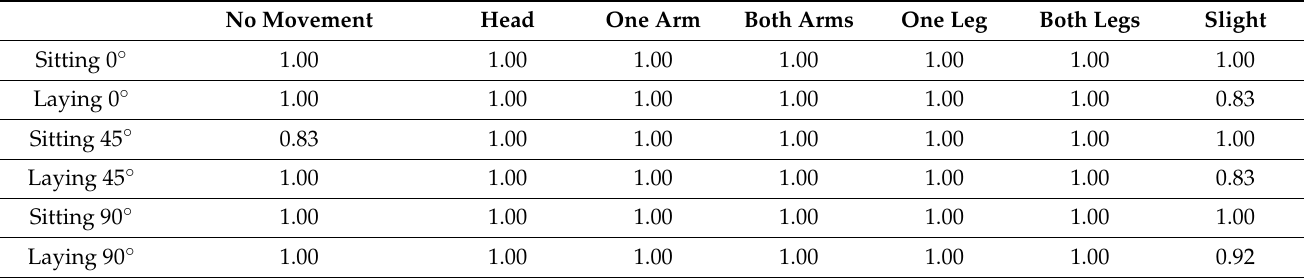
Table 6. Ratio of correctly predicted classes for each position, angle, and movement for the RGB data from the 12-subject group (each approx. 0.08 accounts for a corrected predicted